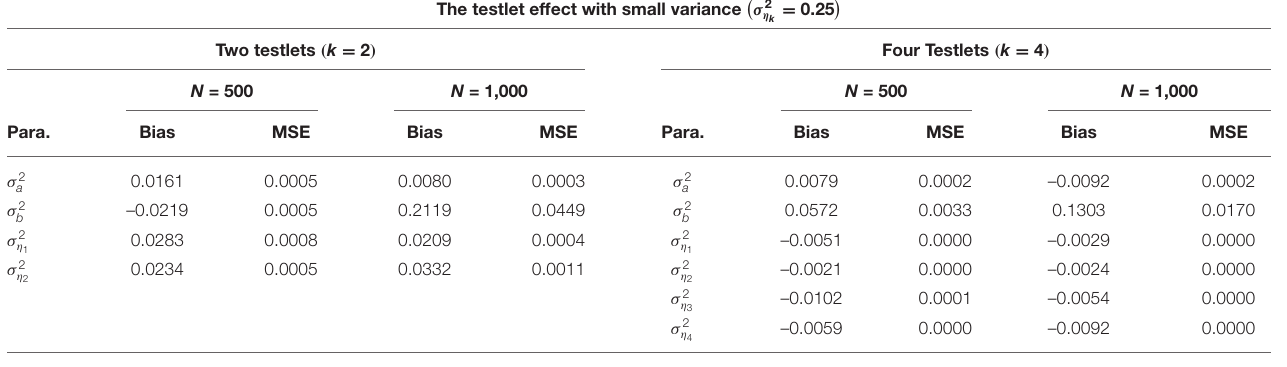
The testlet effect with small